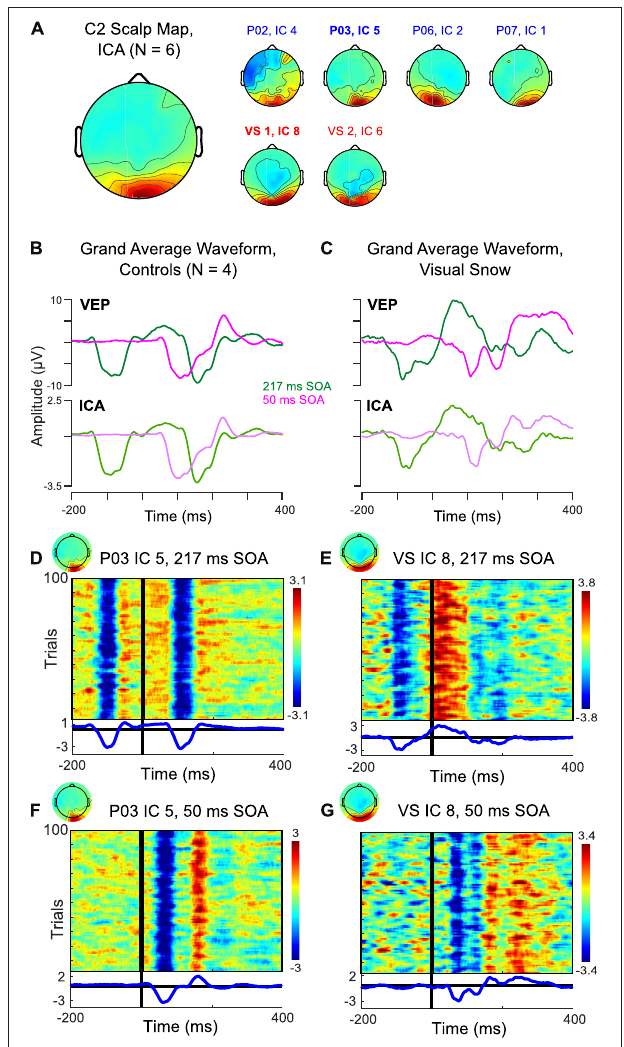
FIGURE 2 | Independent component analysis (ICA) of C2 response. (A) Scalp topography associated with C2 IC across 4 controls (blue) and 2 sessions in the visual snow patient (red). (B,C) Comparison of back-projected grand average waveform from ICA to C2 VEP measured at the scalp in (B) controls and (C) visual snow patient. (D–G) Plots of trial-by-trial activity associated with C2 IC in (D) a representative control participant at 217ms SOA, (E) the visual snow patient at 217ms SOA, (F) a representative control participant at 50ms SOA, and (G) the visual snow patient at 50ms